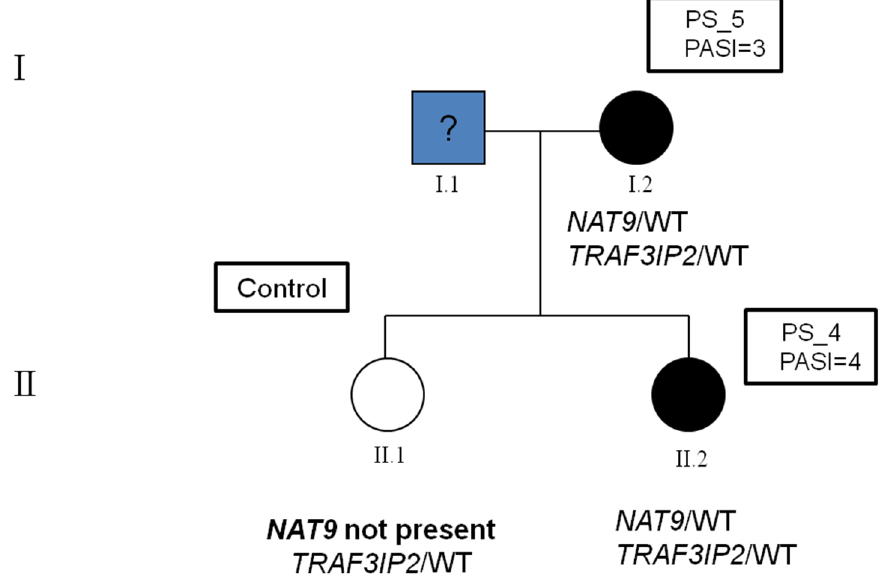
Figure 2. The pedigree of the family under examination and the variants found. The mother (PS_5 and PASI = 3) (proband) contracted plaque-psoriasis at 20 years of age and was found to carry both variants in TRAF3IP2 and NAT9 in a heterozygous status. Her daughter (PS_4 and PASI = 4) was affected by plaque-psoriasis at the age of 18 years and she carried the same two variants as her mother. The presence of the two variants was also checked in the family control (the non-affected daughter) and she was found to carry in the variant in TRAF3IP2 in heterozygous status but was wild type for the variant in the NAT9 gene.